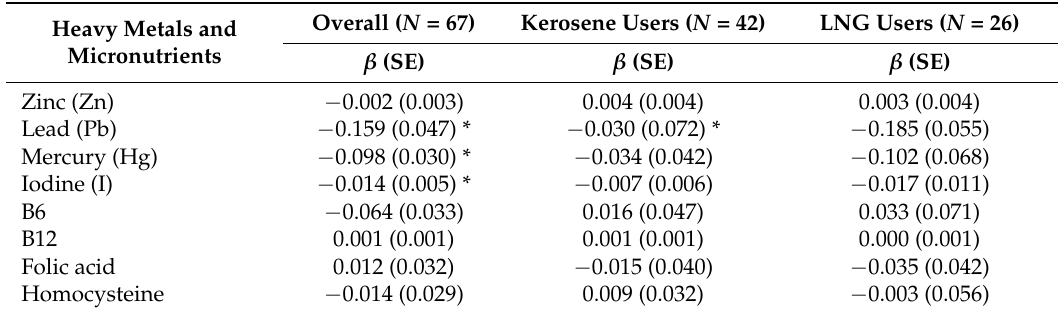
Table 4. Associations † between micronutrients and heavy metals in maternal blood and birth weight stratified by cooking fuel